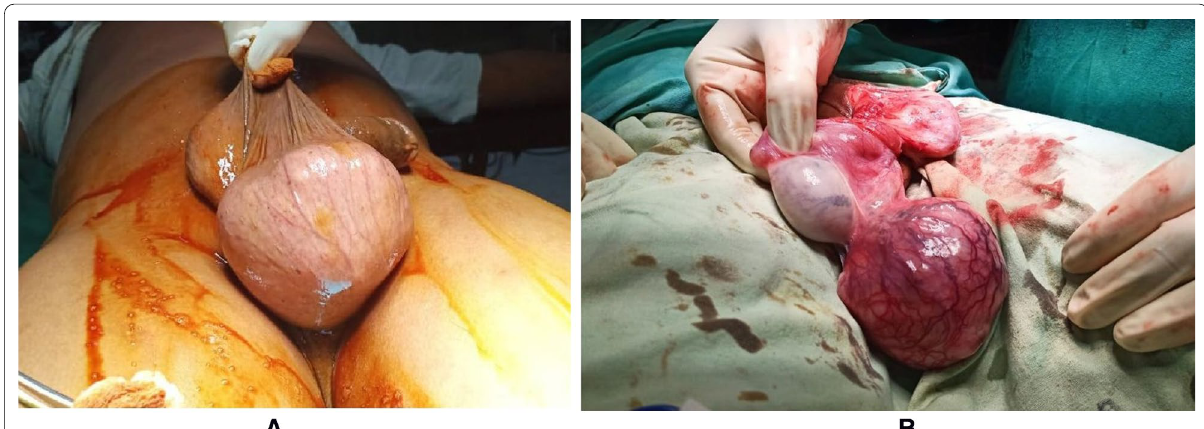
Fig. 1 a Pre-operative clinical image of the scrotum showing the paratesticular mass, b Intra operative image showing paratesticular mass separate from the